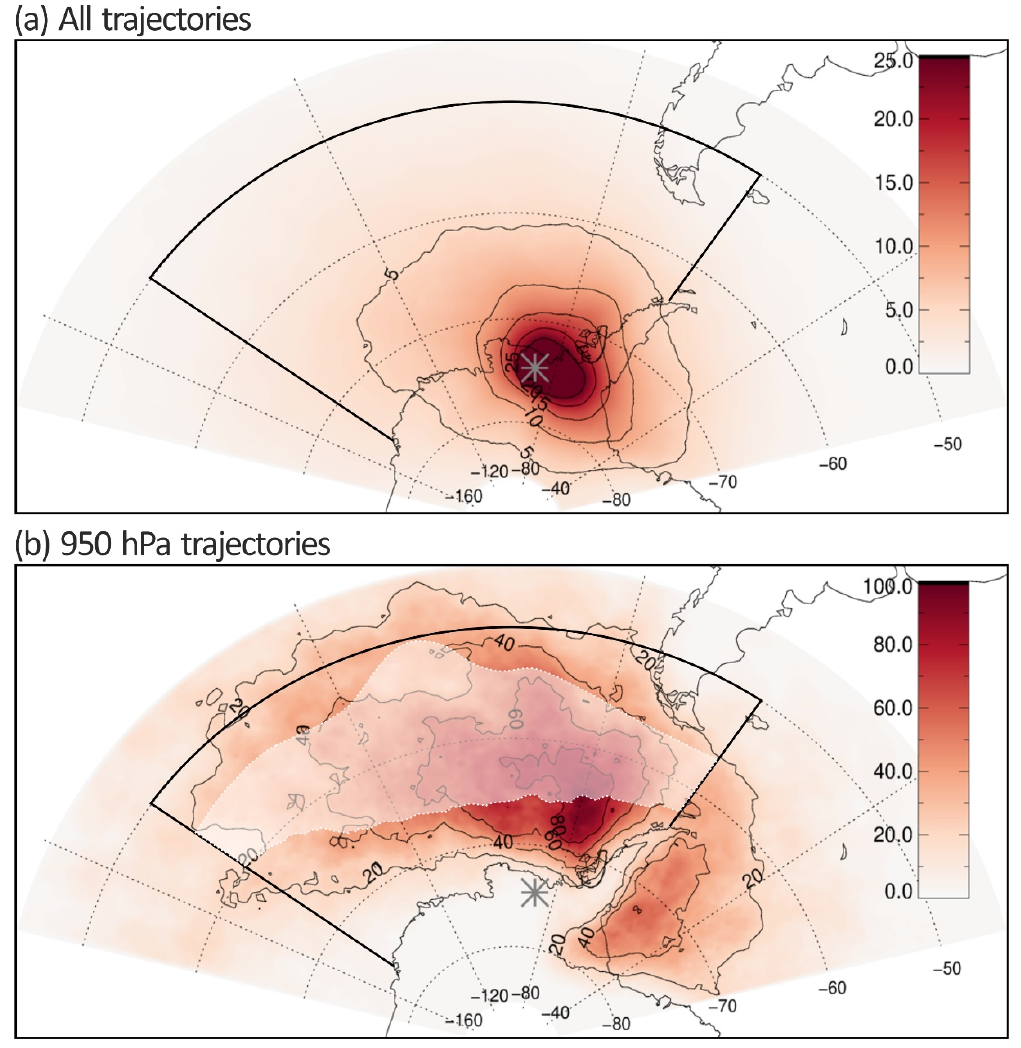
Figure 6. Density plots of 5-day back-trajectories reaching the Ferrigno ice core site (1980–2010) for ( a ) percentage of all trajectories (adapted from Thomas and Bracegirdle [44]); ( b ) all trajectories passing below 950 hPa with corresponding area of the NAZ for the Amundsen and Bellingshausen Seas illustrated by the white transparent overlay. Grey star indicates the location of the Ferrigno ice core; black outline marks the Amundsen and Bellingshausen Seas region.